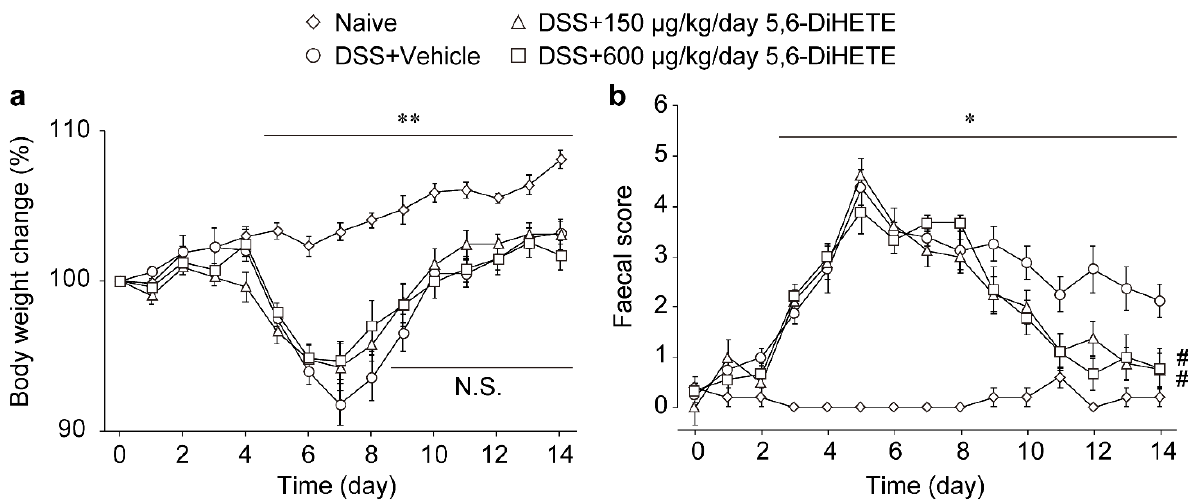
Figure 2. Effects of oral administration of 5,6-DiHETE on the body weight change or faecal score. ( a ) Body weight and ( b ) faecal scores were assessed as pathological markers (n = 5 – 9). Body weight was normalized by that of day 0. Data are represented as mean ± SEM. * p < 0.05, ** p < 0.01 between Naive and DSS + Vehicle. # p < 0.05, compared with DSS + Vehicle. N.S., not significant between DSS + Vehicle, DSS + 5,6- DiHETE (150 μg/kg/day) and DS S + 5,6-DiHETE (600 μg/kg/day). Naive, non-treated healthy mice; DSS + Vehicle, vehicle-treated DSS colitis mice; DSS + 5,6- DiHETE (150 μg/kg/day), 150 μg/kg/day of 5,6 -DiHETE-treated DSS colitis mice; DSS + 5,6- DiHETE (600 μg/kg/day), 600 μg/kg/day of 5,6 -DiHETE- treated DSS colitis mice.